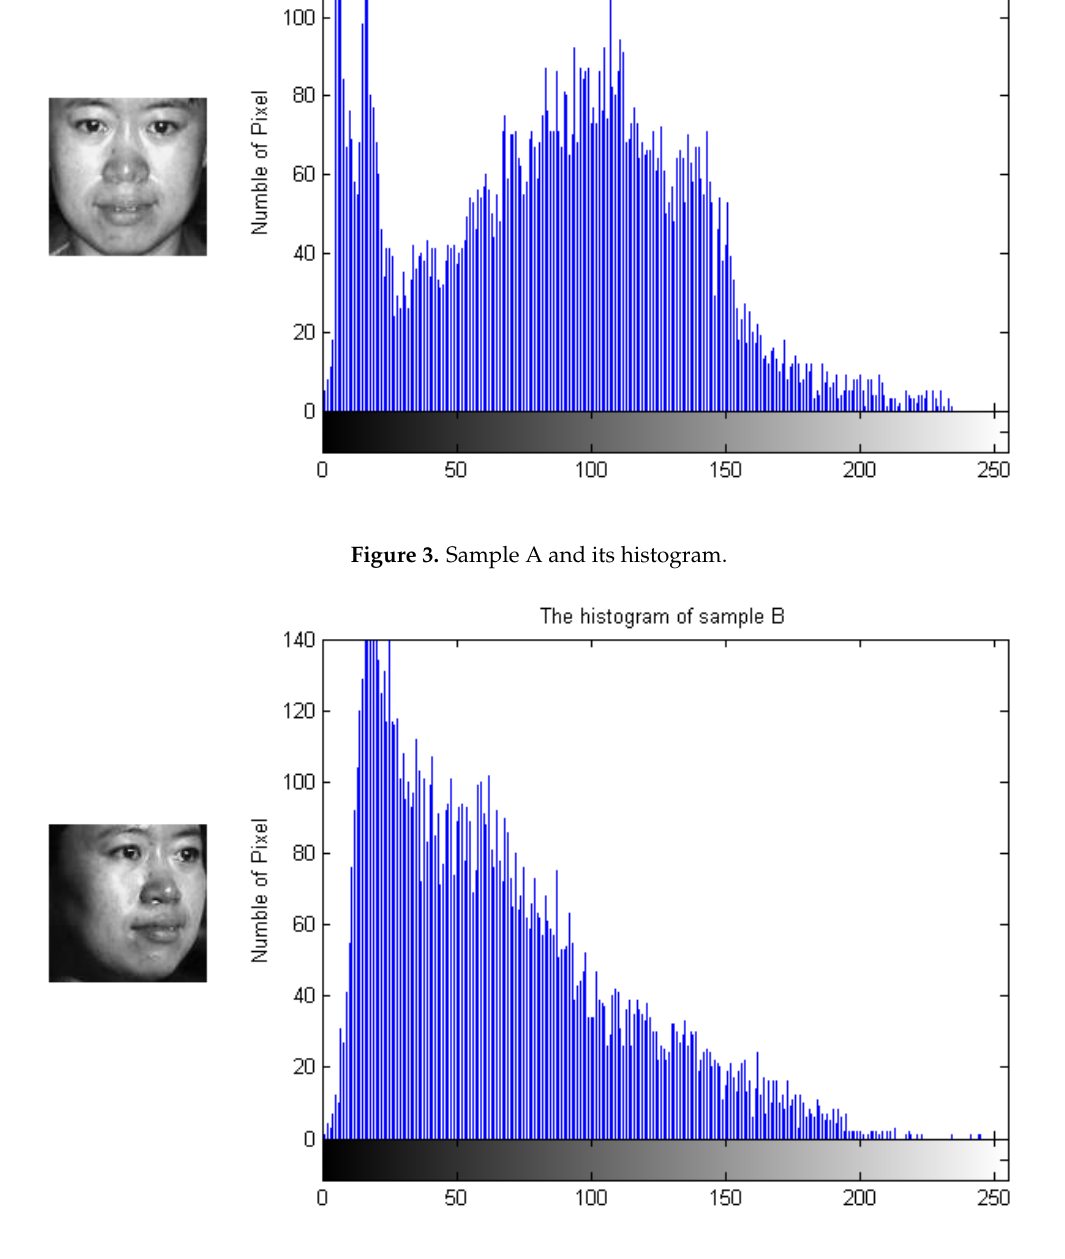
Figure 4. Sample B and its